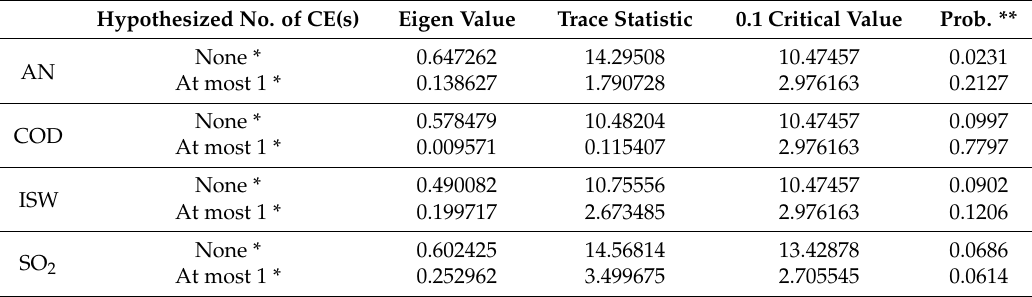
Table 8. Johansen co-integration test for petroleum and natural gas extraction.